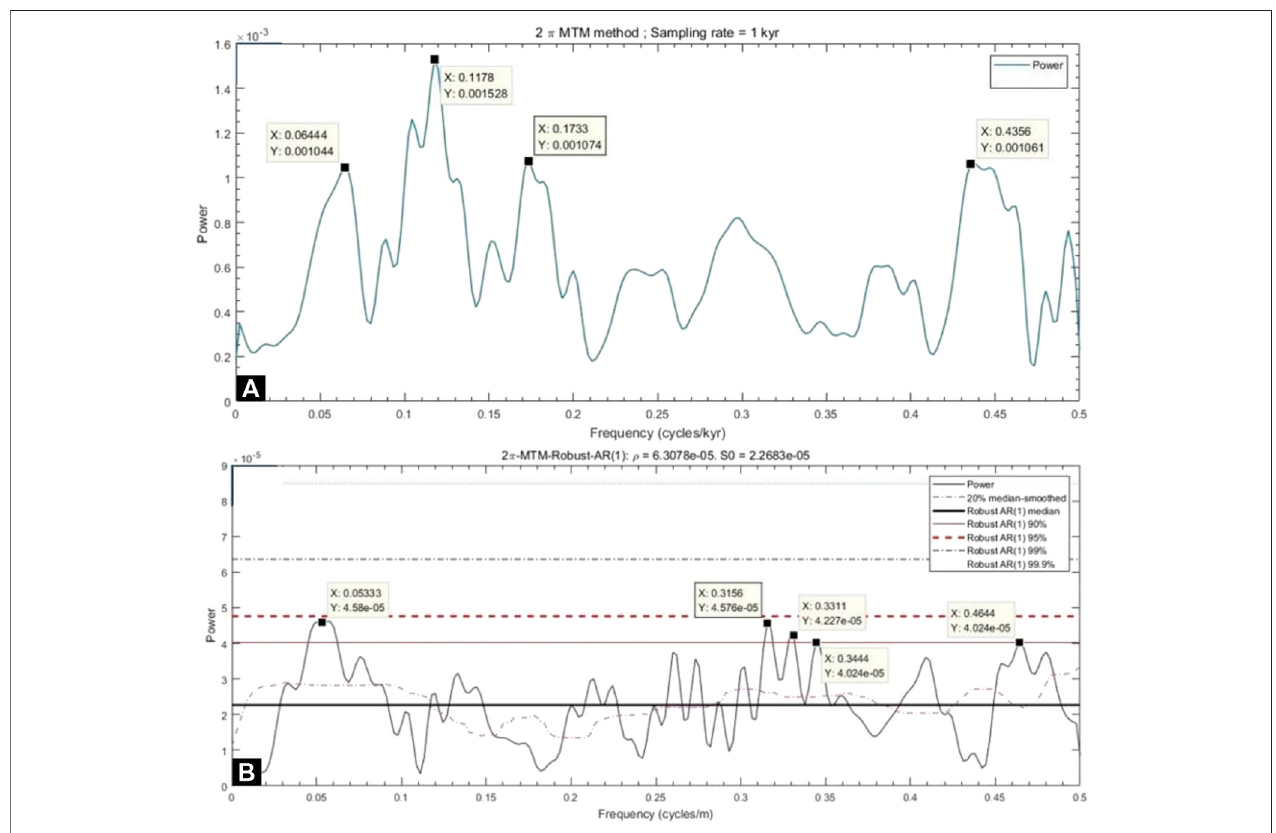
FIGURE 6 | Time series analysis power spectrum and scale analysis power spectrum.